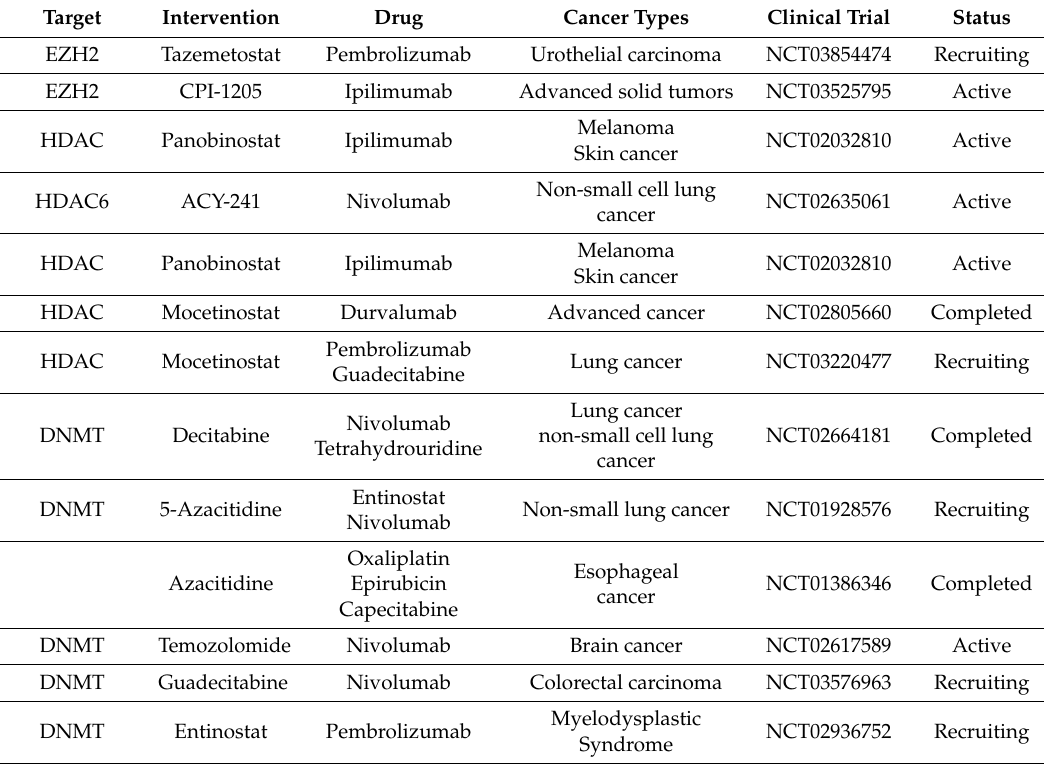
Table 3. Clinical trials of epigenetic therapy combined with